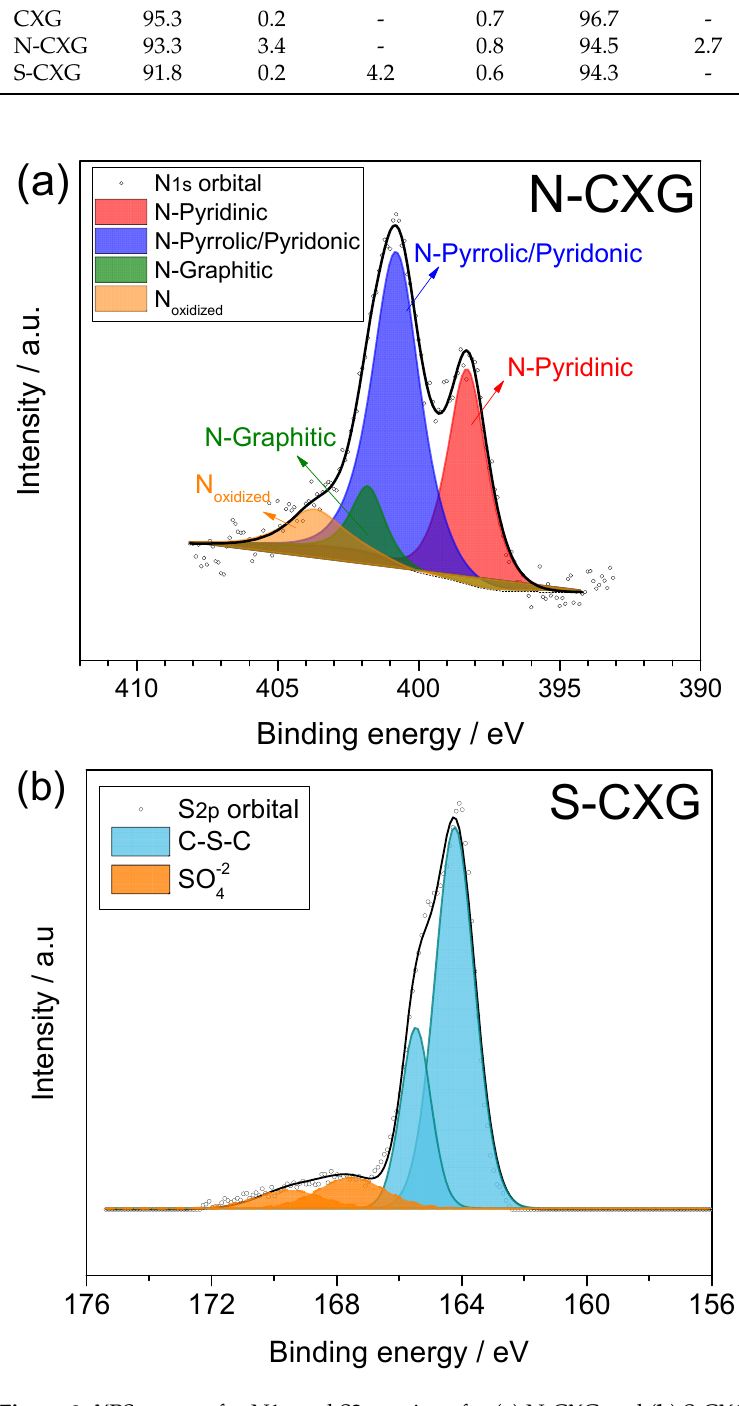
Figure 2. XPS spectra for N1s and S2p regions for ( a ) N-CXG and ( b ) S-CXG, respectively. XPS spectra were deconvoluted for each doped sample. N-CXG (Figure 2a) presented five N functionalities: pyridinic N (398.2 eV), pyrrolic N and pyridonic N (399.7 eV), graphitic N (401.0 eV), and oxidized N (403 eV). N-CXG presents an important contribution of N-pyrrole (54 at. %), followed by N-pyridine (30.8 at. %), and a small amount of graphitic N (7.9%). On the other hand, S-CXG (Figure 2b) was composed of two contributions: